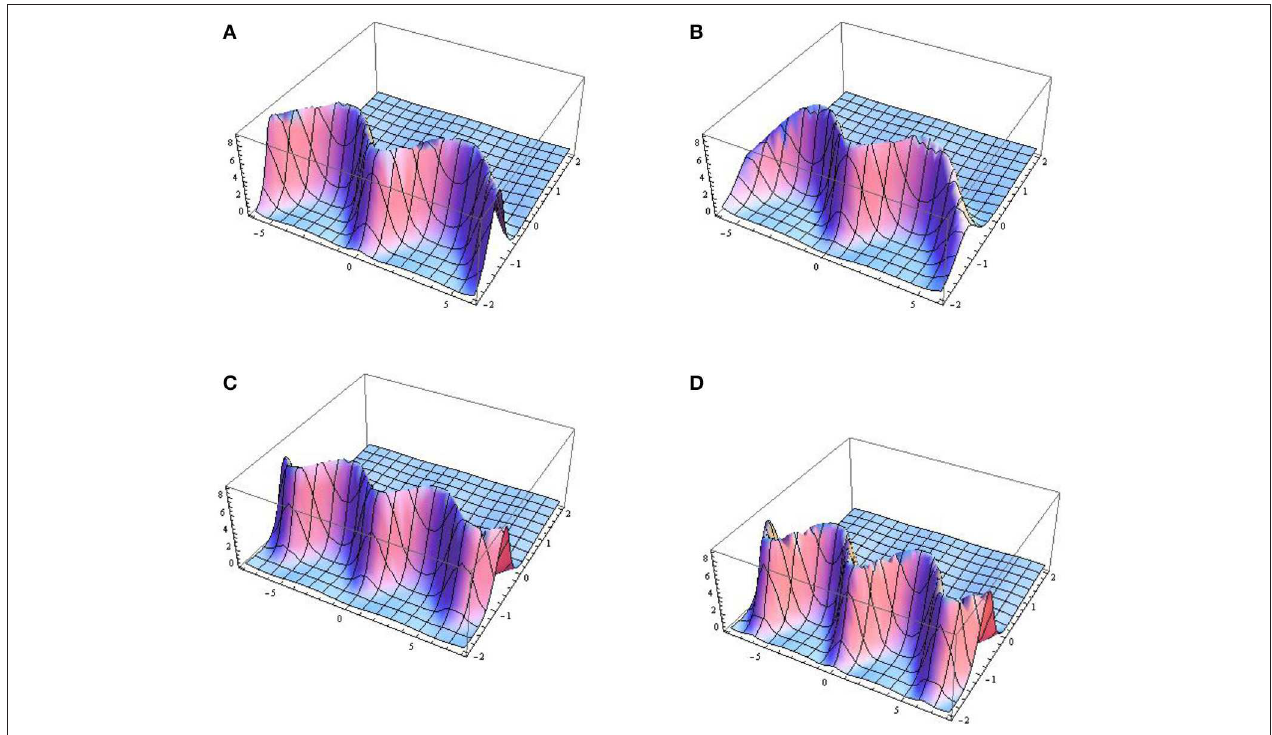
FIGURE 3 | 3D graphical representations of first-order rogue waves. The figures correspond with (A) b b 1.5, δ 0 ( t ) exp(0.05 = = δ ( t ) 1.3 0.01cos t , δ 0 ( t ) = +